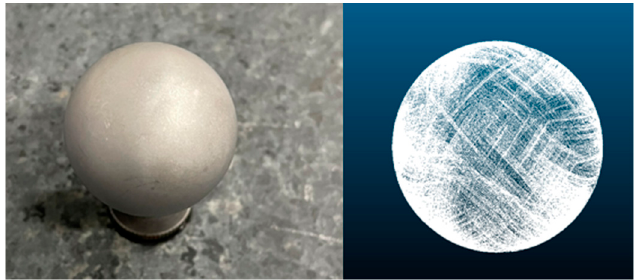
Figure 14. Standard ball scanning result.